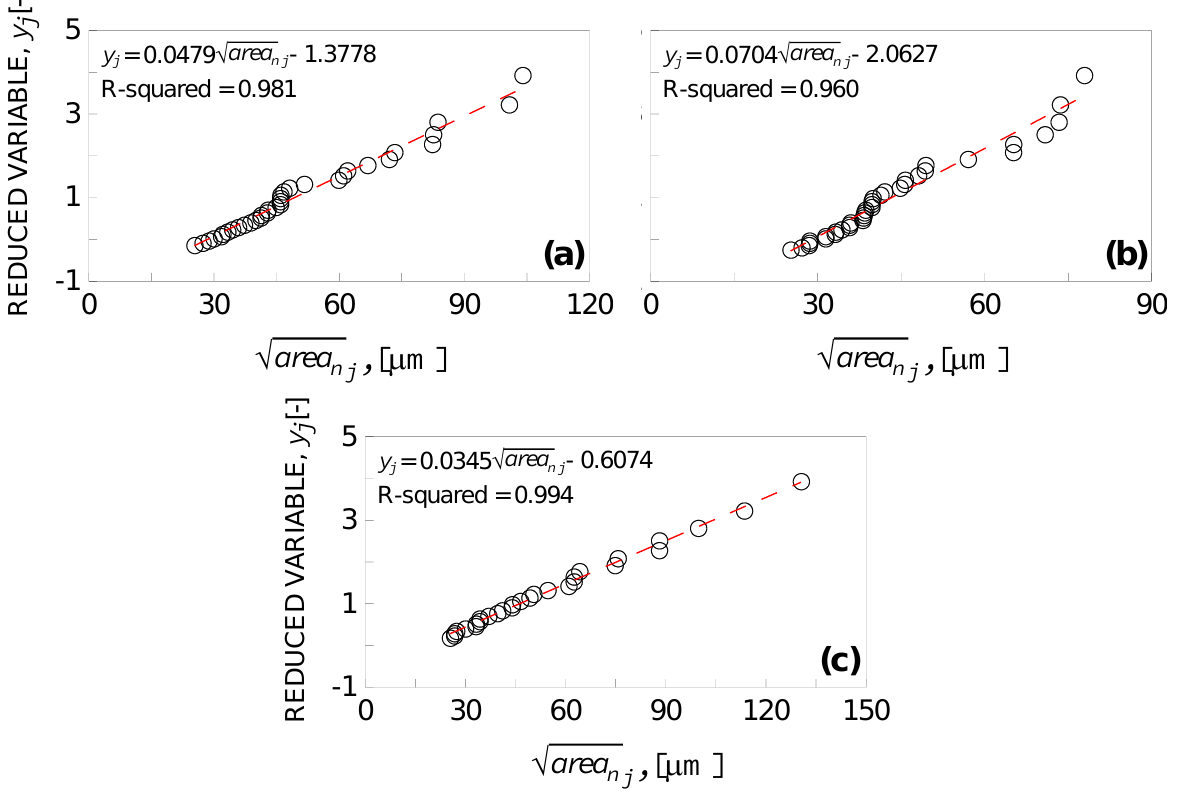
Figure 1. Probability graph of the defect distribution for: ( a ) EN-GJS-400-18 DCI; ( b ) EN-GJS-600-3 DCI; ( c ) EN-GJS-700-2 DCI.